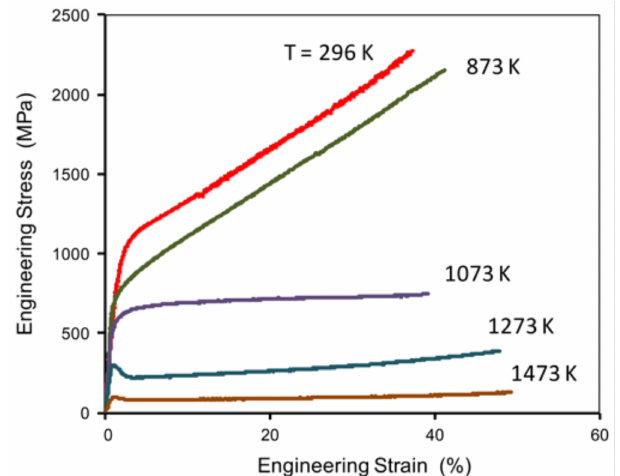
Figure 29. Engineering stress − strain compression curves of TaNbHfZrTi alloy at different tempera- tures determined with a strain rate of 10 − 3 s − 1 . Reprinted with permission from ref. [50]. Copyright 2012 Springer Nature. Table 3. Compression yield strength ( σ 0.2 ) of TaNbHfZrTi alloy at different temperatures ( T ). Adapted from ref. [50].